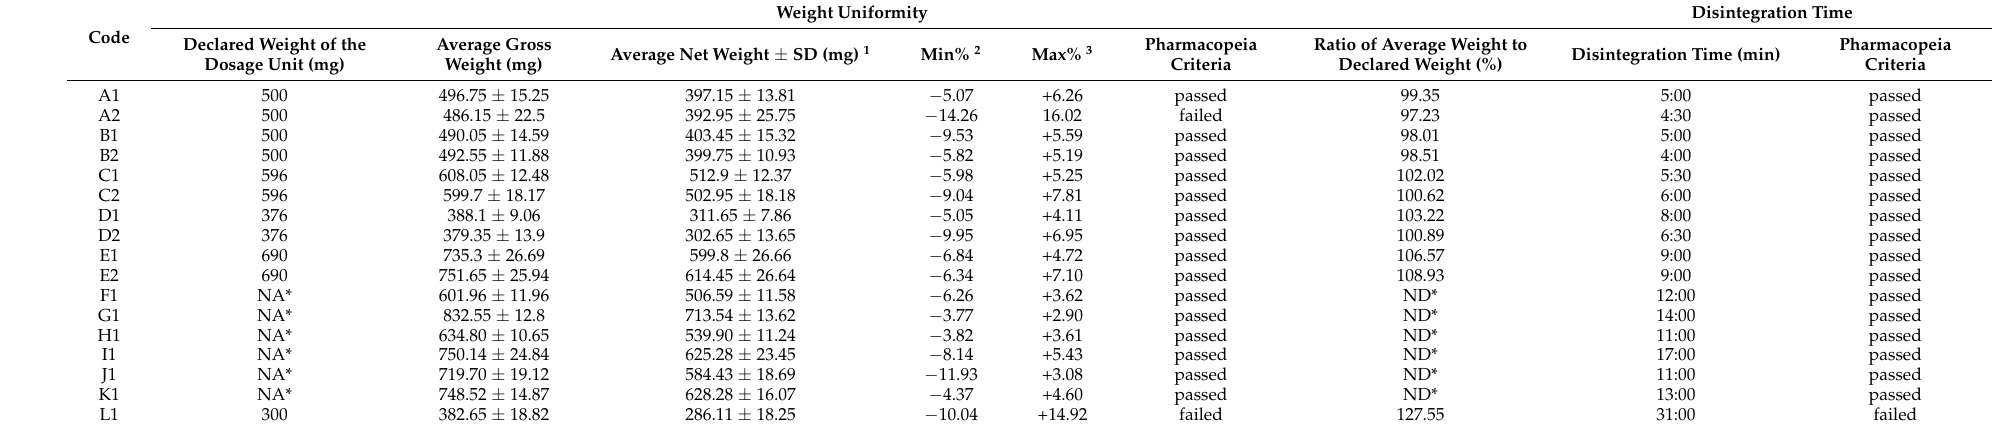
Table 1. Physical parameters of supplements in capsule form.